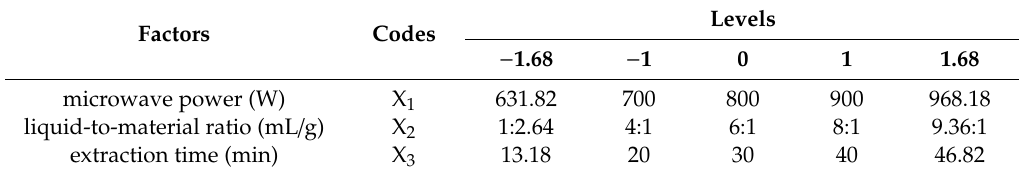
Table 4. The factors and levels of the response surface methodology (RSM)